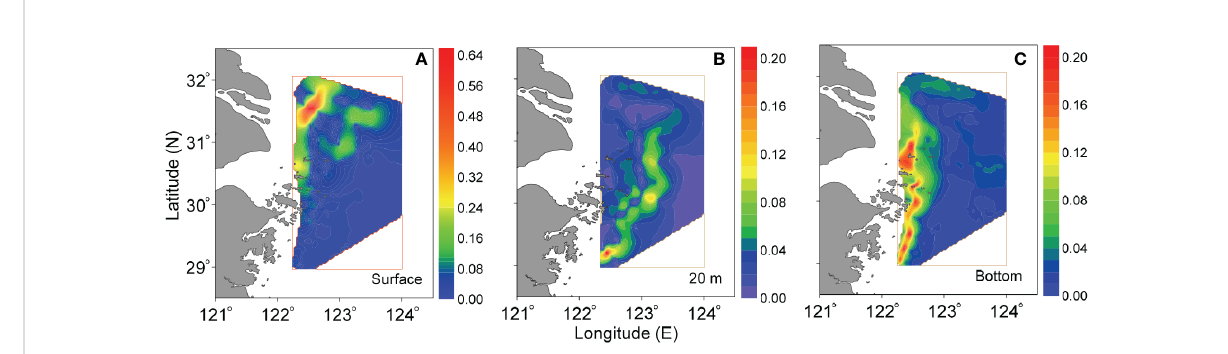
FIGURE 10 Horizontal distributions of density gradient (kg m -3 km -1 ) at (A) surface, (B) 20-m and (C) bottom layers off the CE in August 2013 (the distributions of salinity gradient show similarity and hence are not